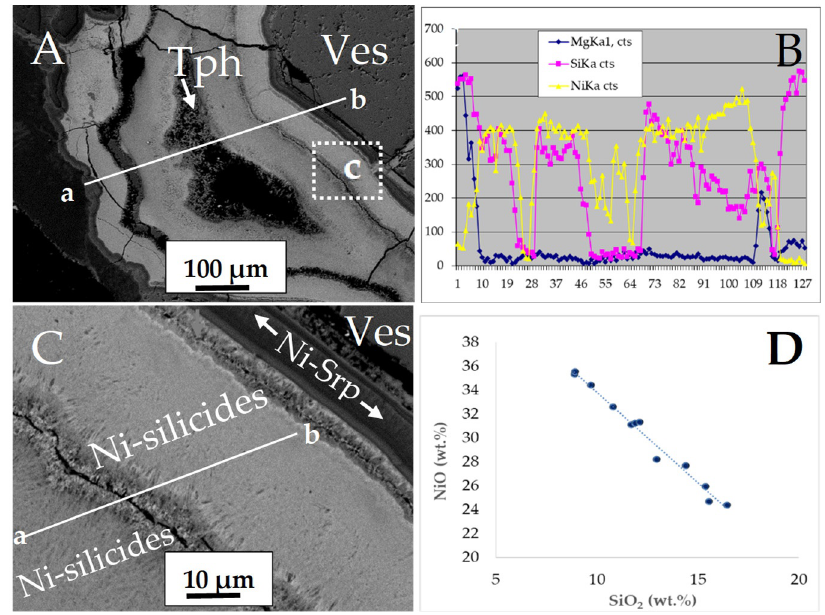
Figure 6. BSE images showing the concentrating development of Ni-silicides and Ni-silicates covering fragmented crystal of vesuvianite ( A ); scan along a–b of a (BSE)-image showing a wide variation of major elements Si, Ni and Mg, with the presence of Ni only at an early stage of theophrastite precipitation ( B ); close-up image of silicides ( C ); plots of NiO versus SiO 2 (wt.%) in the compositions of silicides ( D ). Data source: present work and Economou-Eliopoulos and Eliopoulos [12]. In general, Ni is mainly hosted Ni-rich serpentine and theophrastite (Figure 5) and in less extent into chlorite and serpentine, all cross-cutting earlier (Ni-Co-Mn)-hydroxides with a concentering development and a wide compositional variation (Figure 6). The (Co,Mn,Ni)-hydroxides showing a concentering development and a wide compositional variation and are crosscut often by serpentine and Ni-serpentine veins (Figures 4B and 7A), which clearly postdate the precipitation of the